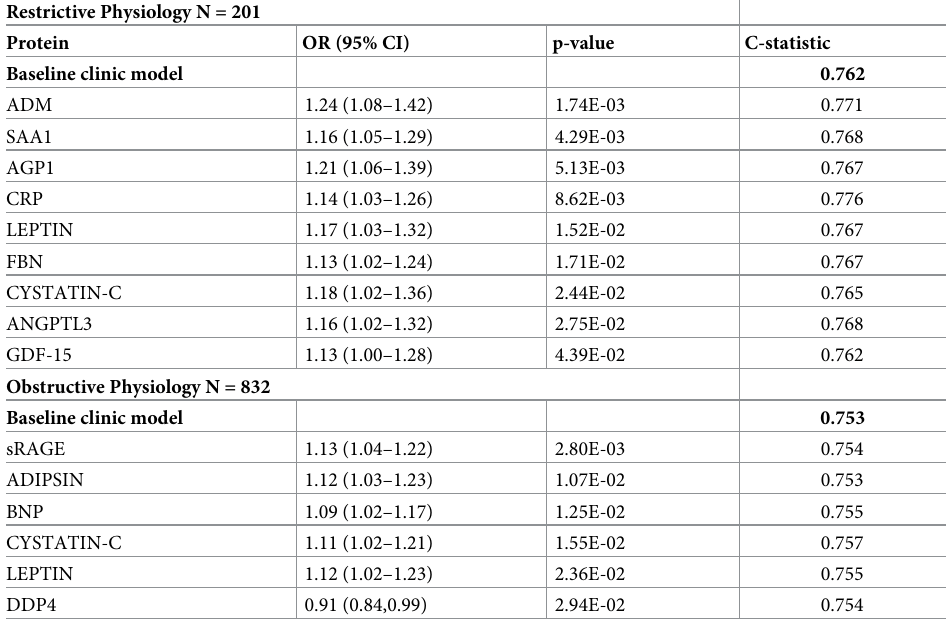
Table 3. Cross-sectional association of cardiovascular disease related plasma proteins with restrictive and obstructive physiology.